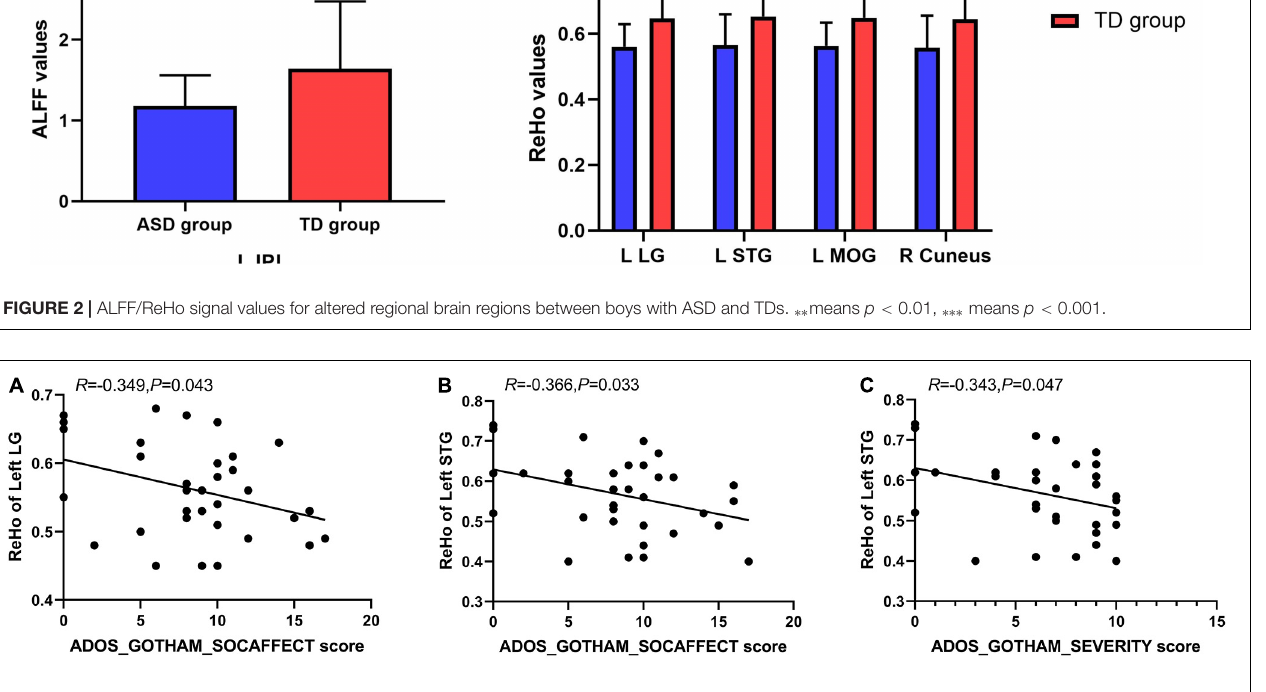
FIGURE 3 | Negative correlation between ReHo values of left LG with ADOS_GOTHAM_SOCAFFECT score (A) , and between ReHo values of left STG with ADOS_GOTHAM_SOCAFFECT score (B) ; Negative correlation between the ReHo values of left STG with ADOS_GOTHAM_SEVERITY score (C)